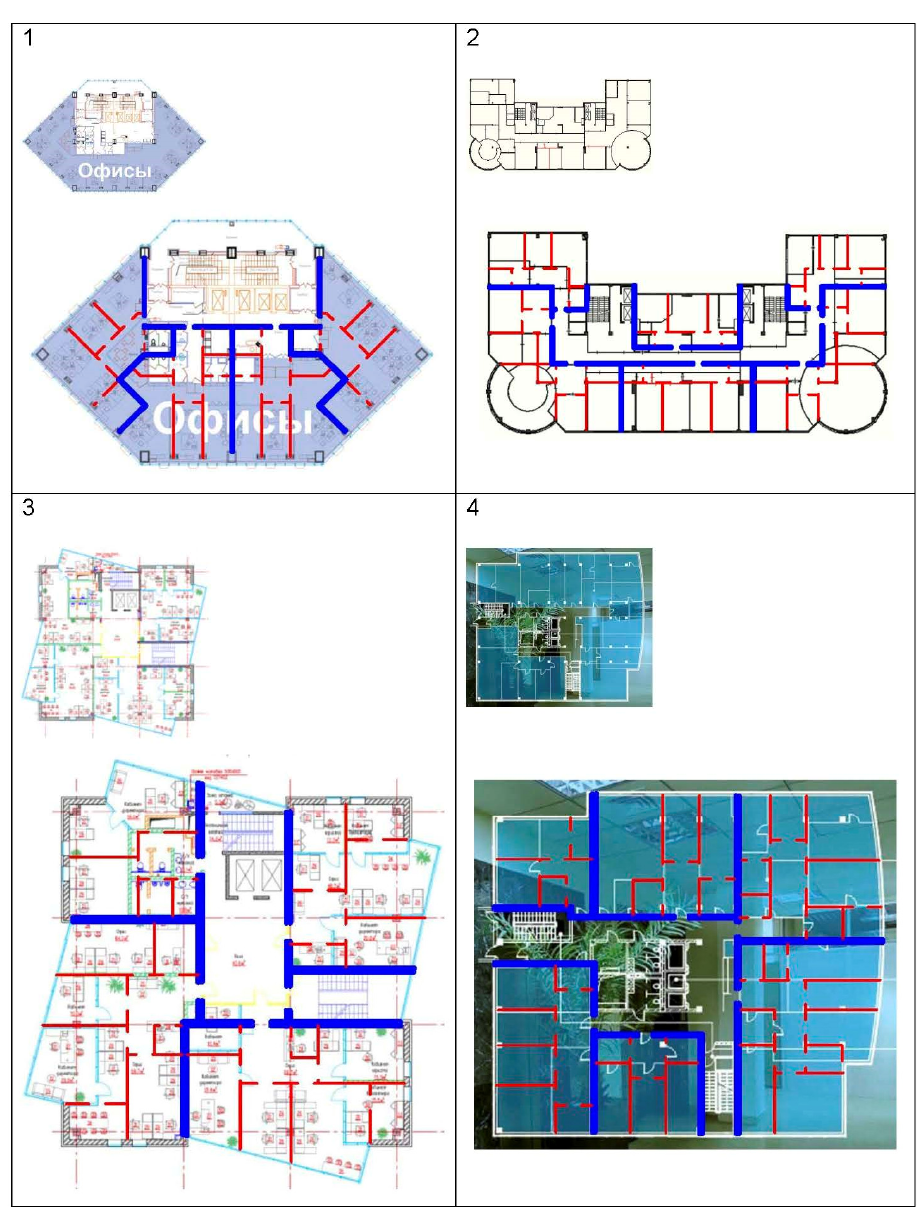
Figure 28. Business center redevelopment options—apartments (authors’ drawings based on existing layouts [97,125,159,160]): ( 1 ) the Almaty Towers, Almaty; ( 2 ) the Nursaulet, Astana; ( 3 ) the Seven, Astana; and ( 4 ) the City Kostanay, Kostanay.